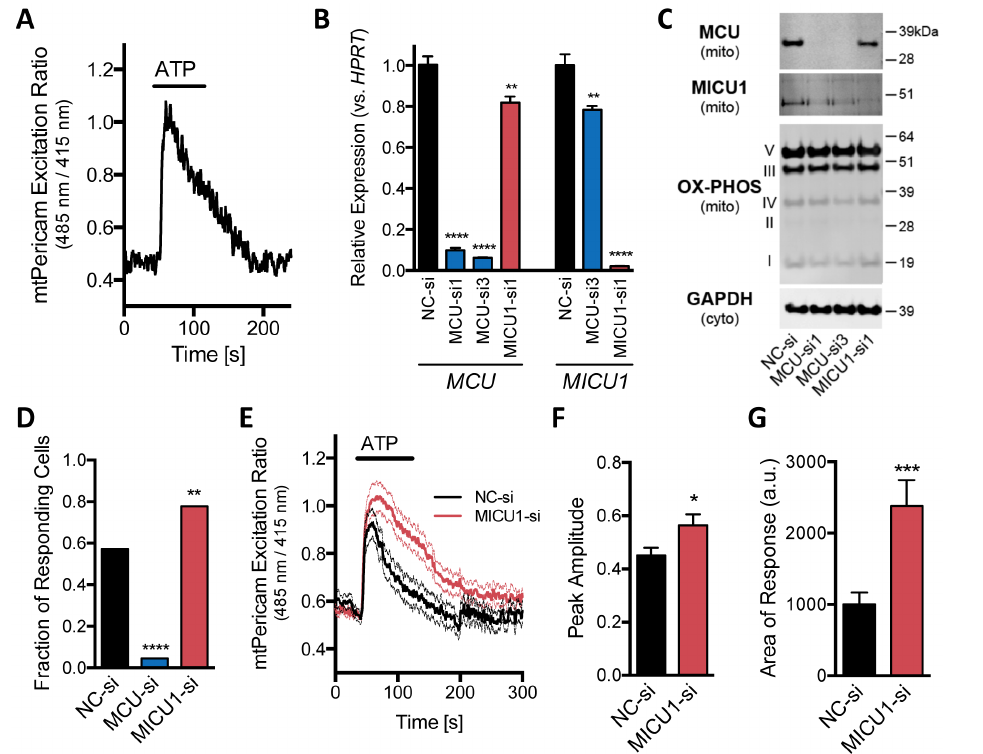
Figure 2. MDA-MB-231 mitochondrial Ca 2 + influx is abrogated and enhanced by MCU and MICU1 knockdown, respectively. A. MDA- MB-231 mitochondria are capable of taking up Ca 2 + in response extracellular stimulation. An example mt-Pericam recording from an adenovirally transduced cell during cellular stimulation with 100 m M ATP for the indicated duration. Mitochondrial Ca 2 + levels were monitored from the ratio of its dual excitation absorbances (485 nm/415 nm) on emission (535 nm). B, C. Efficient down-regulation of MCU and MICU1 mRNA as determined by qPCR ( B ) and protein ( C ) after transient siRNA transfection. NC-si, negative control siRNA. For immunoblots (C), cells were fractionated into cytosolic and mitochondrial fractions prior to SDS-PAGE, as indicated. D. Fraction of mt-Pericam positive cells responding to 100 m M extracellular ATP application is significantly reduced after MCU knockdown (n=44, p , 0.0001. Fisher’s exact test) and increased after MICU1 knockdown (n=63, p , 0.01) compared to NC-si (n=129). E. Average mt-Pericam signals in response to 100 m M ATP as indicated in siRNA transfected cells. Averages are shown as bold lines with SEM as fine lines. F, G. Summary data of mt-Pericam responses calculated for peak amplitude above baseline (F) and area under of the curve (G). Data are mean + / 2 SEM,